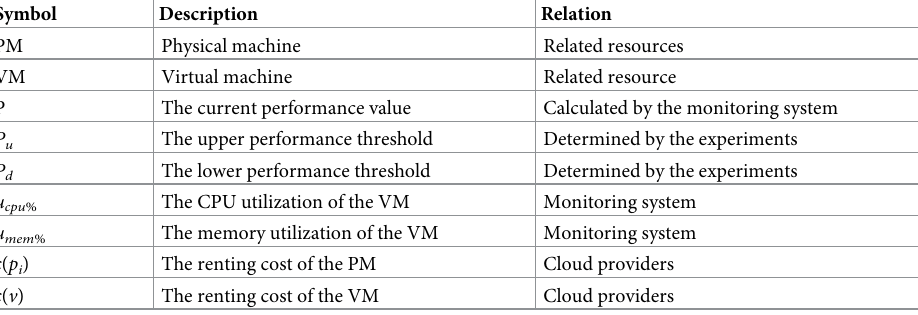
Table 3. The summary of the notations in the ERP